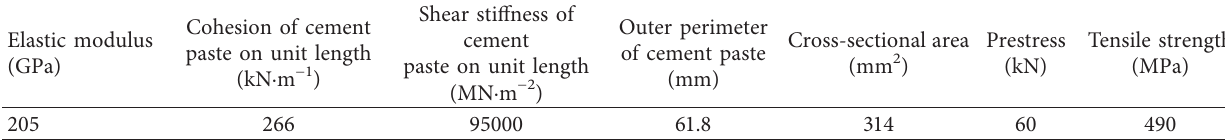
Table 3: Parameters for bolt simulation.